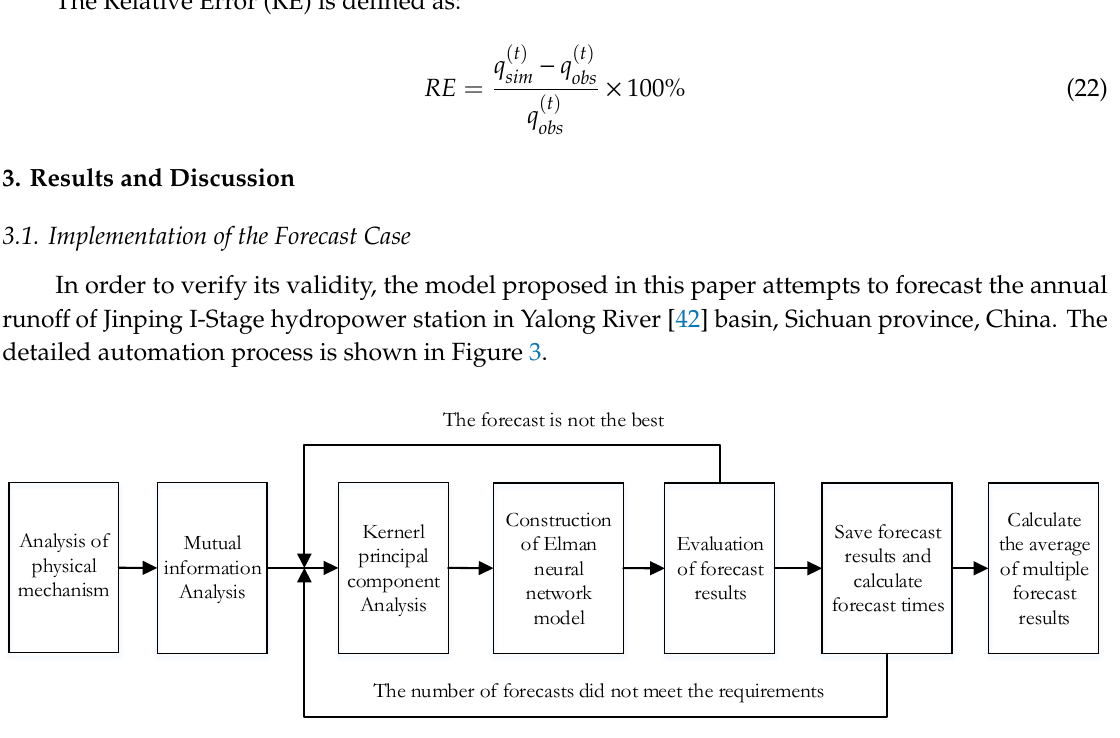
Figure 3. Automatic iteration flow chart for runoff forecasting.